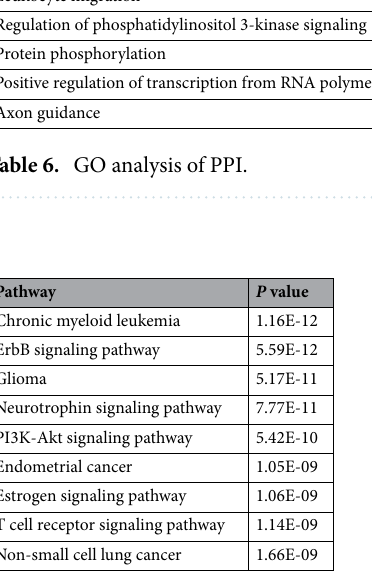
Table 7. KEGG analysis of